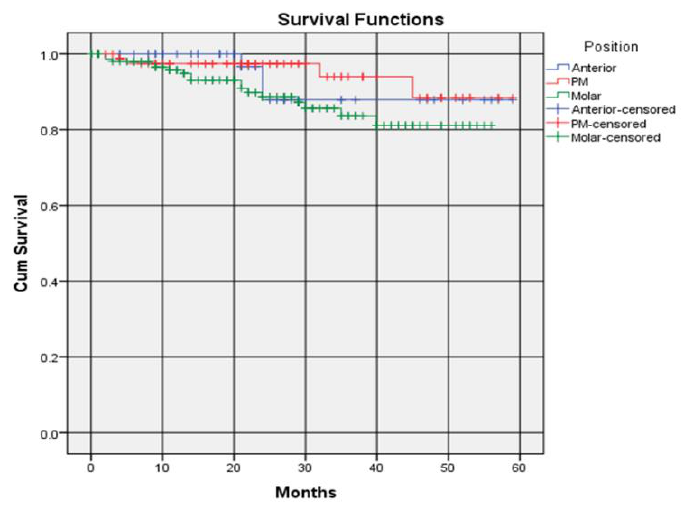
(Table 6). The average survival times were 4.446 ± 0.179 and 4.276 ± 0.182 for PFM and metal, respectively. Figure 2. Survival rate of all PFM and metal crowns placed by students.